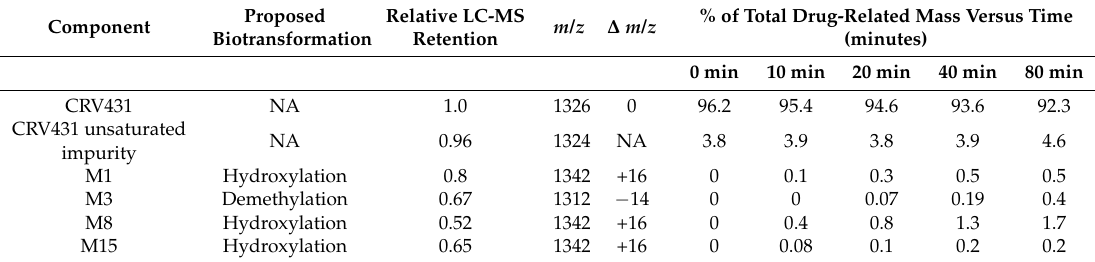
Figure 11. CRV431 metabolism in rat liver microsomes. Rat (Sprague Dawley) liver microsomes (1 mg/mL) were incubated with 1 ug/mL CRV431, and extracts were removed at 0 (panel ( A )), 20 min (panel ( B )), 40 min (panel ( C )), and 80 min (panel ( D )) for analysis by ESI-LCMS. Each LC-MS profile displays the metabolite abundances as a function of chromatographic retention time. Table 6. Identification of CRV431 metabolites in rat liver microsomes. Rat liver microsomes (1 mg/mL) were incubated with 1 ug/mL CRV431, and extracts were removed for analysis by ESI-LCMS. Component Proposed Relative LC-MS Component Biotransformation